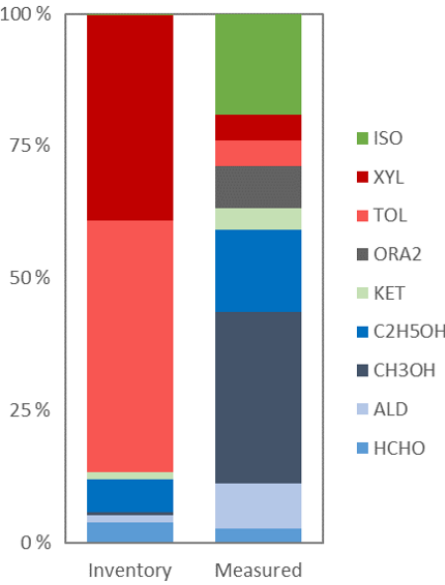
Figure 12. The percentage contribution of the MEIC VOC group- ings to the total